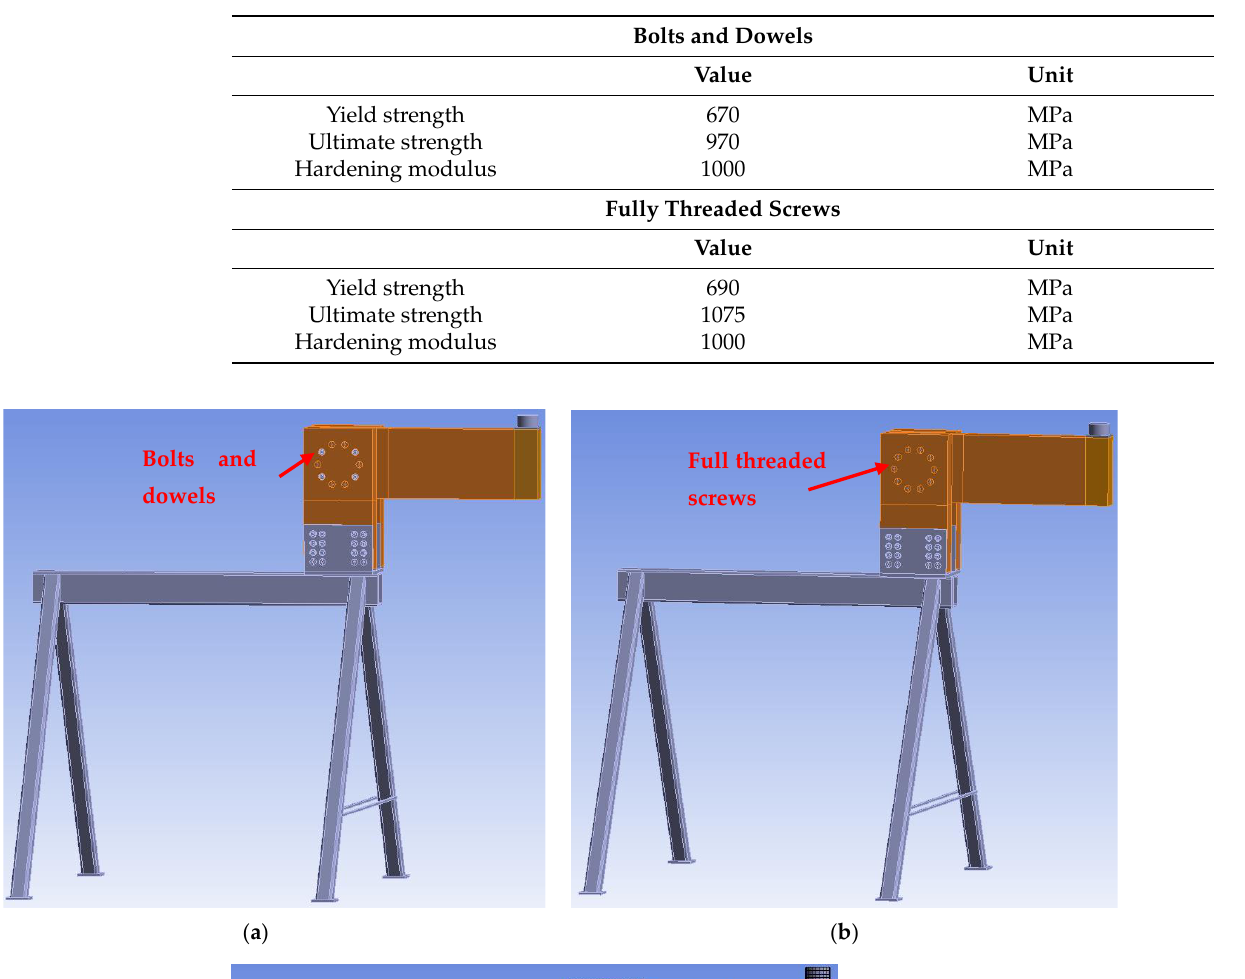
Table 5. Values for the plastic behavior of the material model for steel; see Johanides 2022 [44].